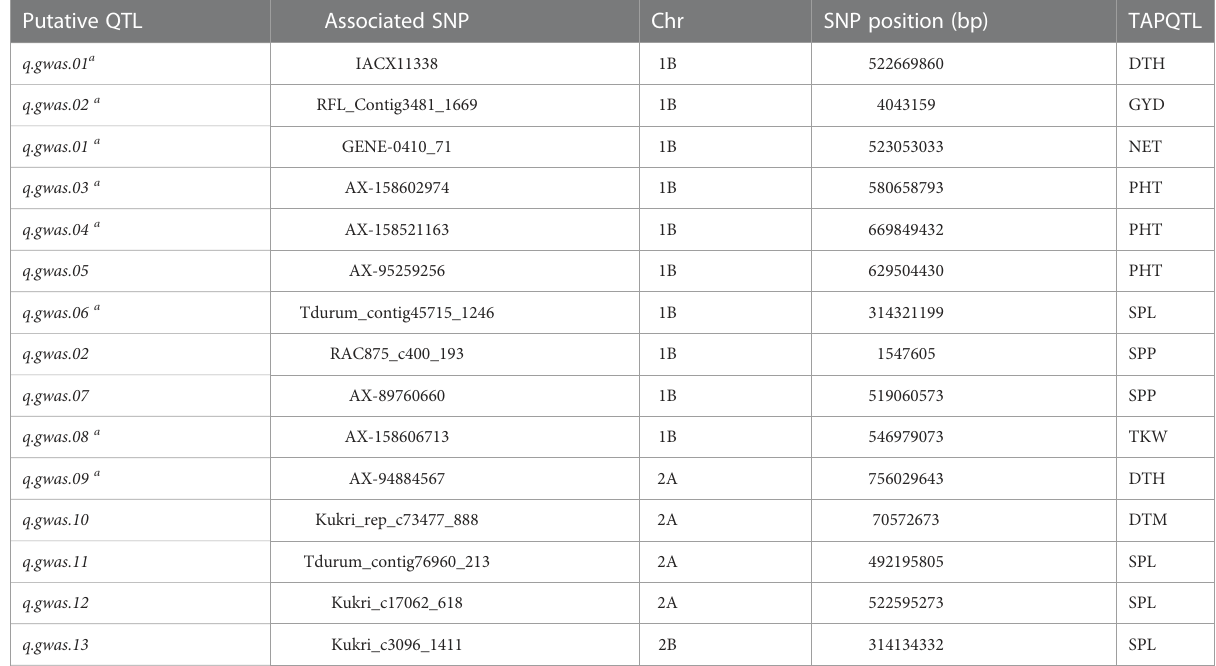
TABLE 5 Summary of putative quantitative trait loci (QTLs) identi fi ed for the nine phenotypic traits analyzed in the present study using Ethiopian durum wheat germplasm. Putative QTL Associated SNP Chr SNP position (bp)